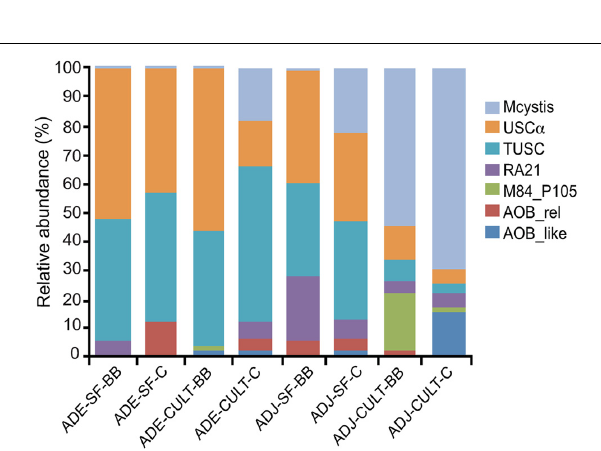
FIGURE 3 | Relative abundance of detected pmoA -related clades obtained by amplicon pyrosequencing ofAmazonian Dark Earth (ADE) and adjacent soils (ADJ) under secondary forest (SF) and manioc cultivation (CULT) at Barro Branco (BB) and Caldeirão (C) sites. The sequence clades are described in the text. “ Mcystis ” indicates Methylocystis